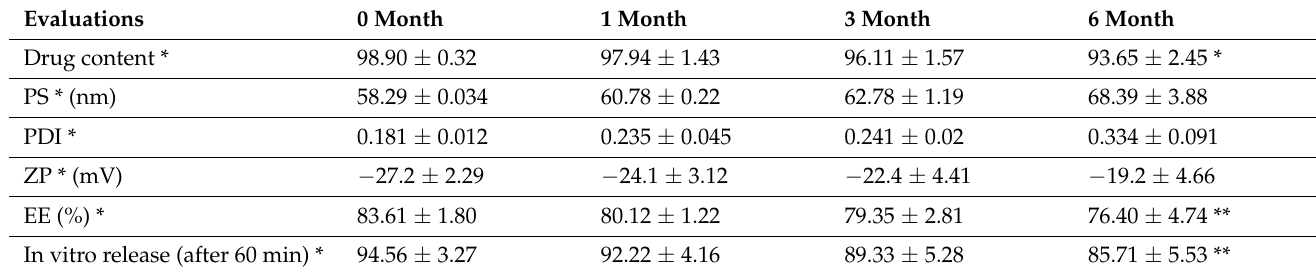
Table 4. Various stability parameters of